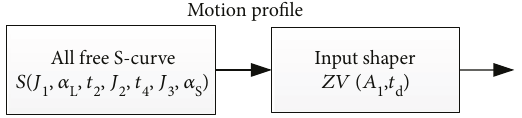
Figure 3: Motion pro fi le generated by AFS-IS.